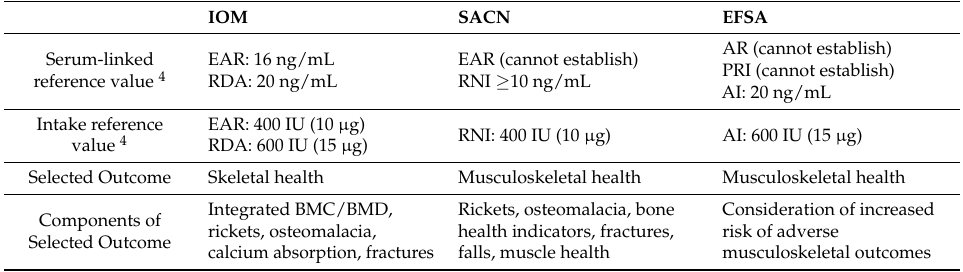
Table 5. Comparison of vitamin D reference values and reported approach: Institute of Medicine 1 , Scientific Advisory Committee on Nutrition (United Kingdom) 2 and European Food Safety Authority 3 . IOM SACN